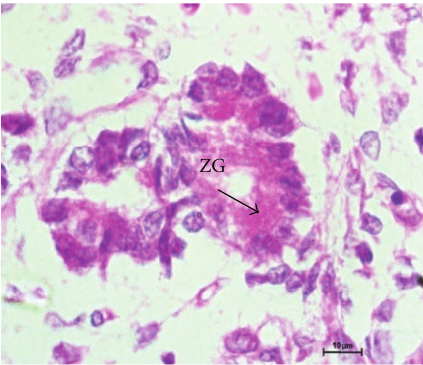
Figure 3: 7.5 cm CVRL (62 days) paraffin section showing acini and zymogen granules (ZG) in apical part of cell. Hematoxylin and eosin × 1000.